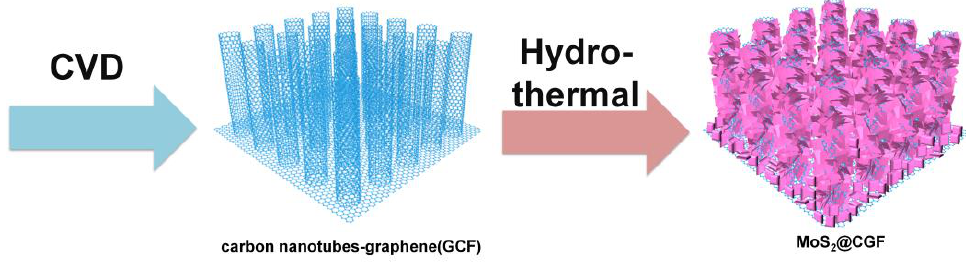
Figure 1. Schematic illustration of the synthesis process of MoS 2 @CGF.